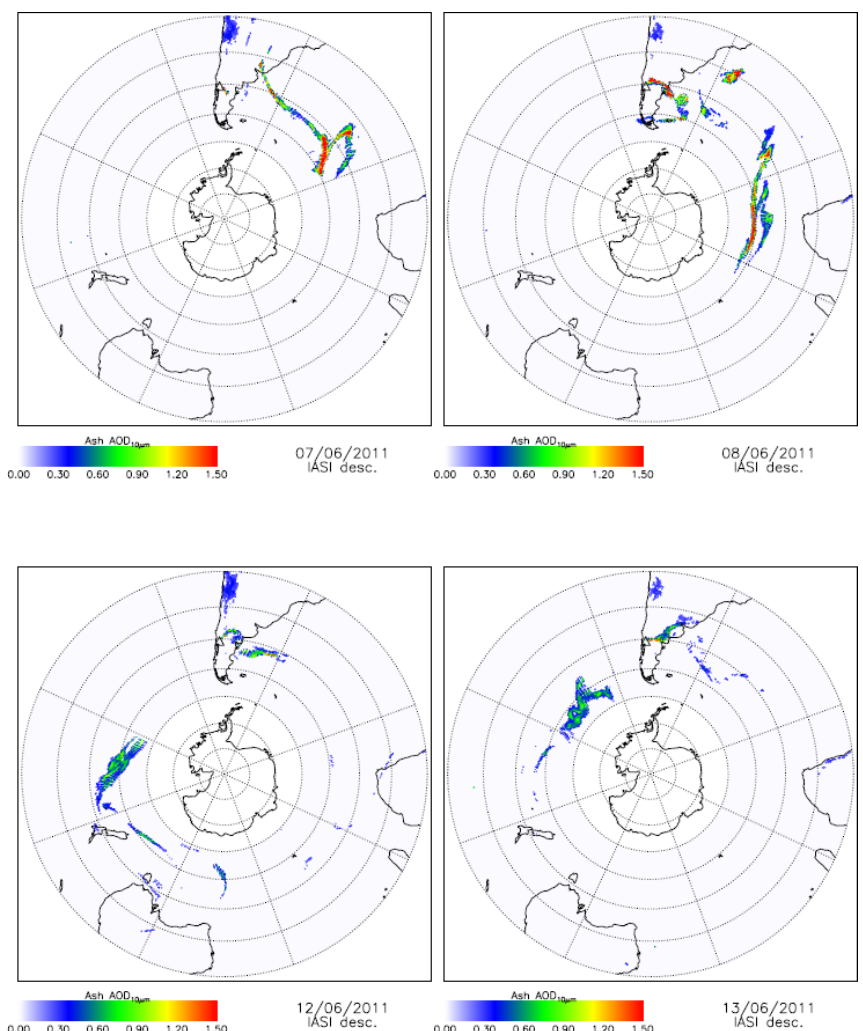
Figure 11. Figure by L. Klüser, T. Ebersteder and J. Meyer-Arnek, published in Klüser et al. (2013) as Fig. 3, with the following description: “The PCCE ash plume on its way around the Southern Hemisphere for descending MetOp orbits from 7, 8, 12 and 13